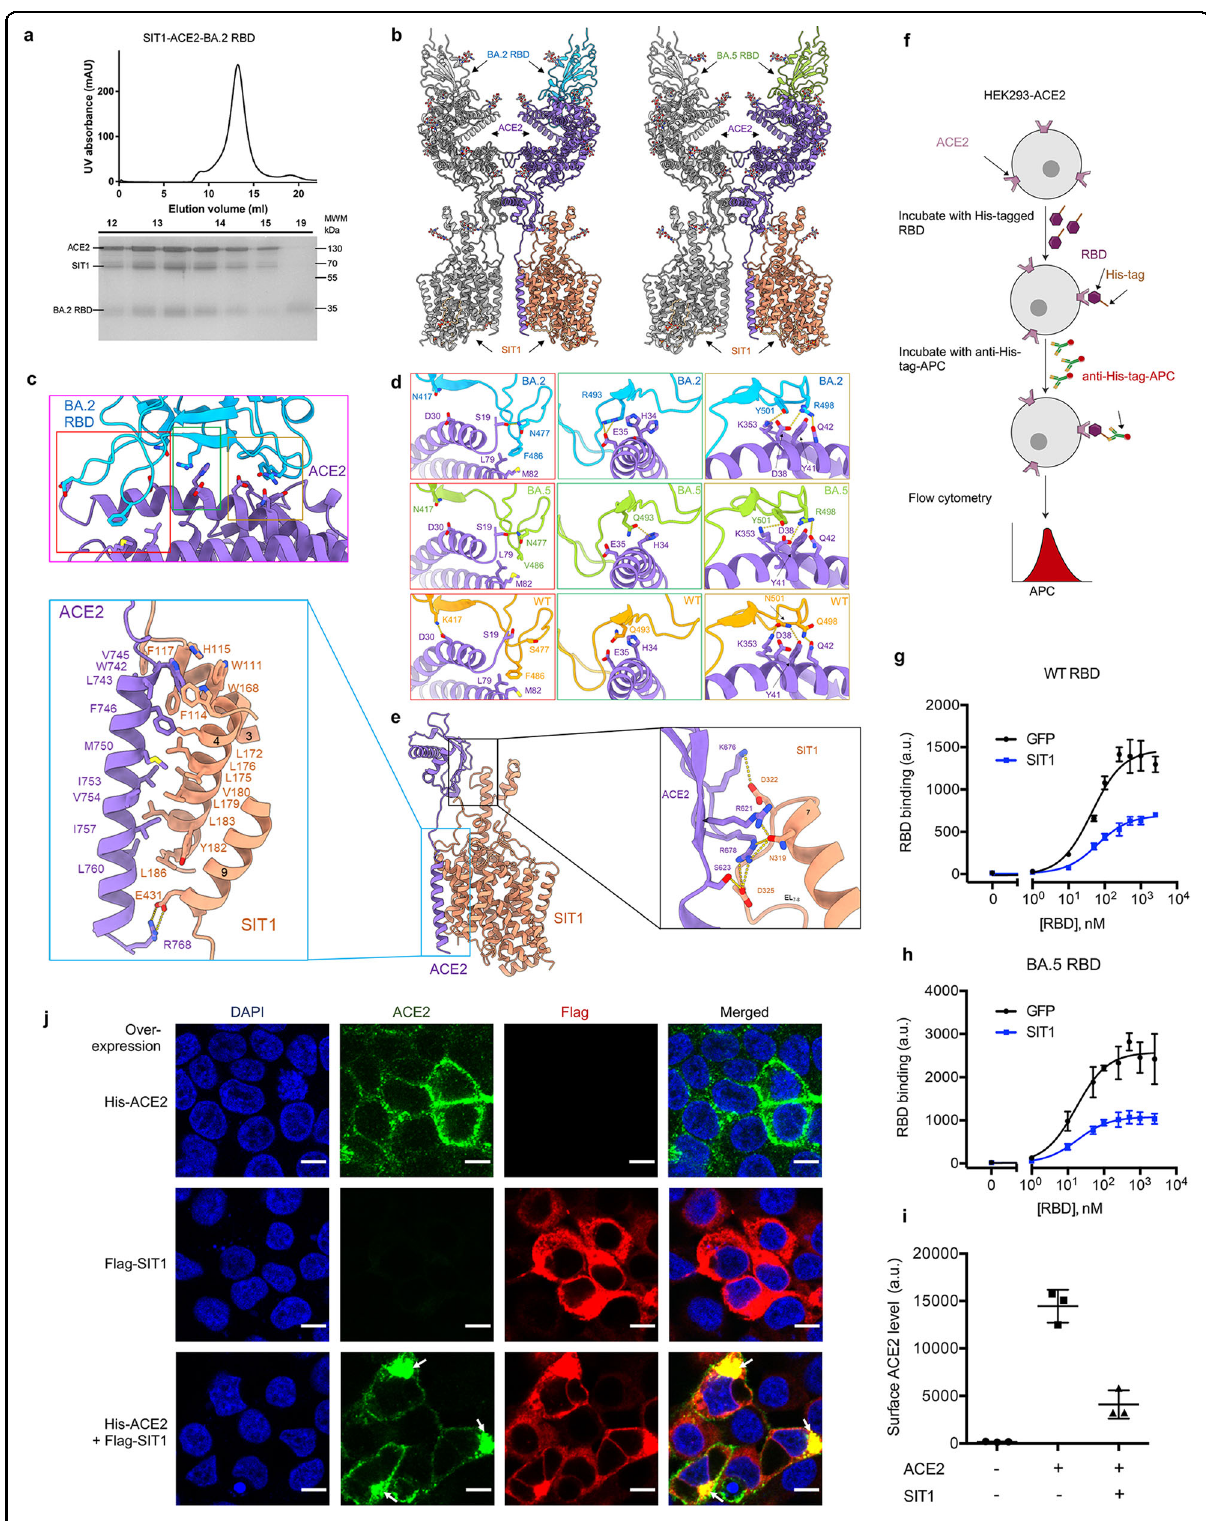
Fig. 1 (See legend on next